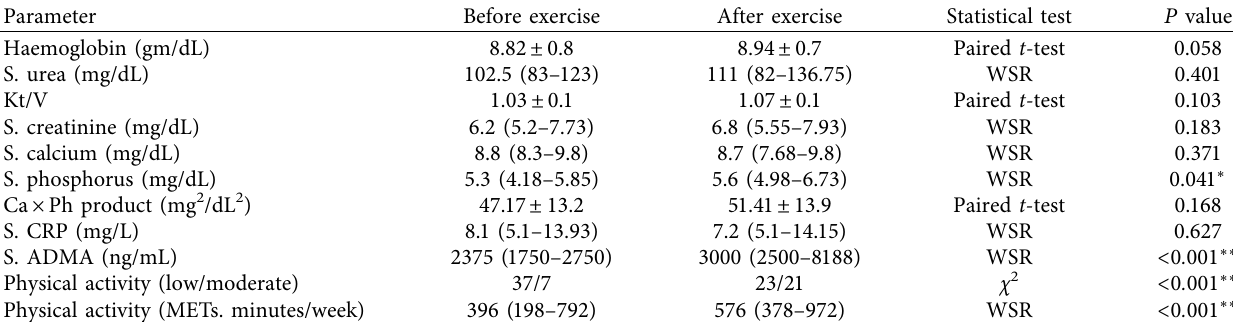
Table 1: Comparison of the study parameters before and after the 6-month exercise program